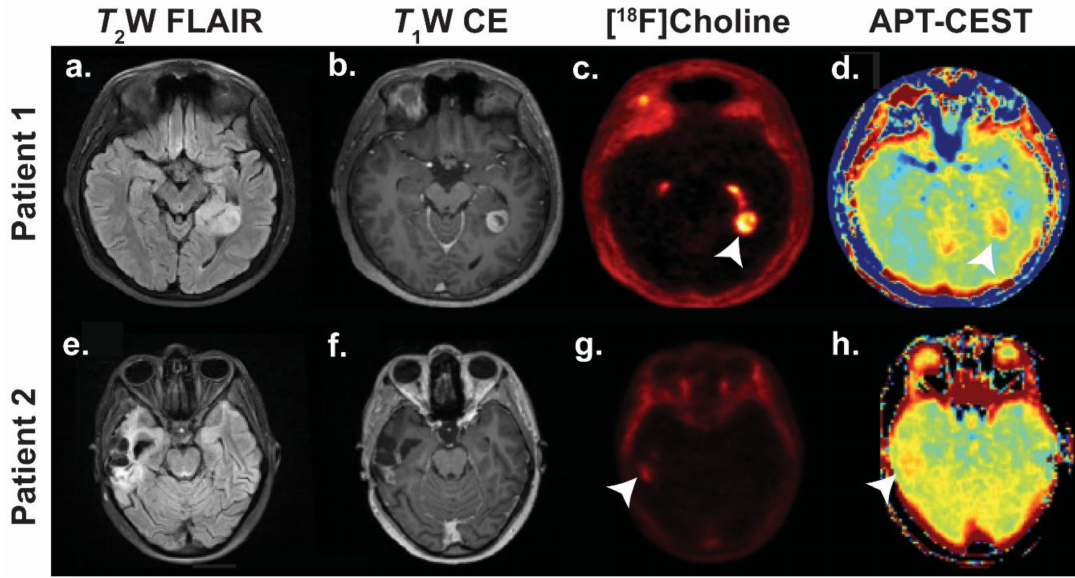
Figure 4. Detection of recurrence in two patients using 18 F-choline and amide proton transfer- chemical exchange saturation transfer (APT-CEST). Patient 1 ( a – d ): WHO grade I pilocytic astrocytoma initially treated with radiotherapy. Imaging performed four years later when the patient re-presented with seizures. Patient 2 ( e – h ): WHO grade IV glioblastoma multiforme treated with surgery and chemoradiotherapy. Imaging surveillance performed eighteen months after completing initial treatment. Tumours indicated with white arrowheads. Abbreviations: T 2 W FLAIR, T 2 -weighted fluid-attenuated inversion recovery; T 1 W CE, T 1 -weighted contrast enhanced. Images courtesy of